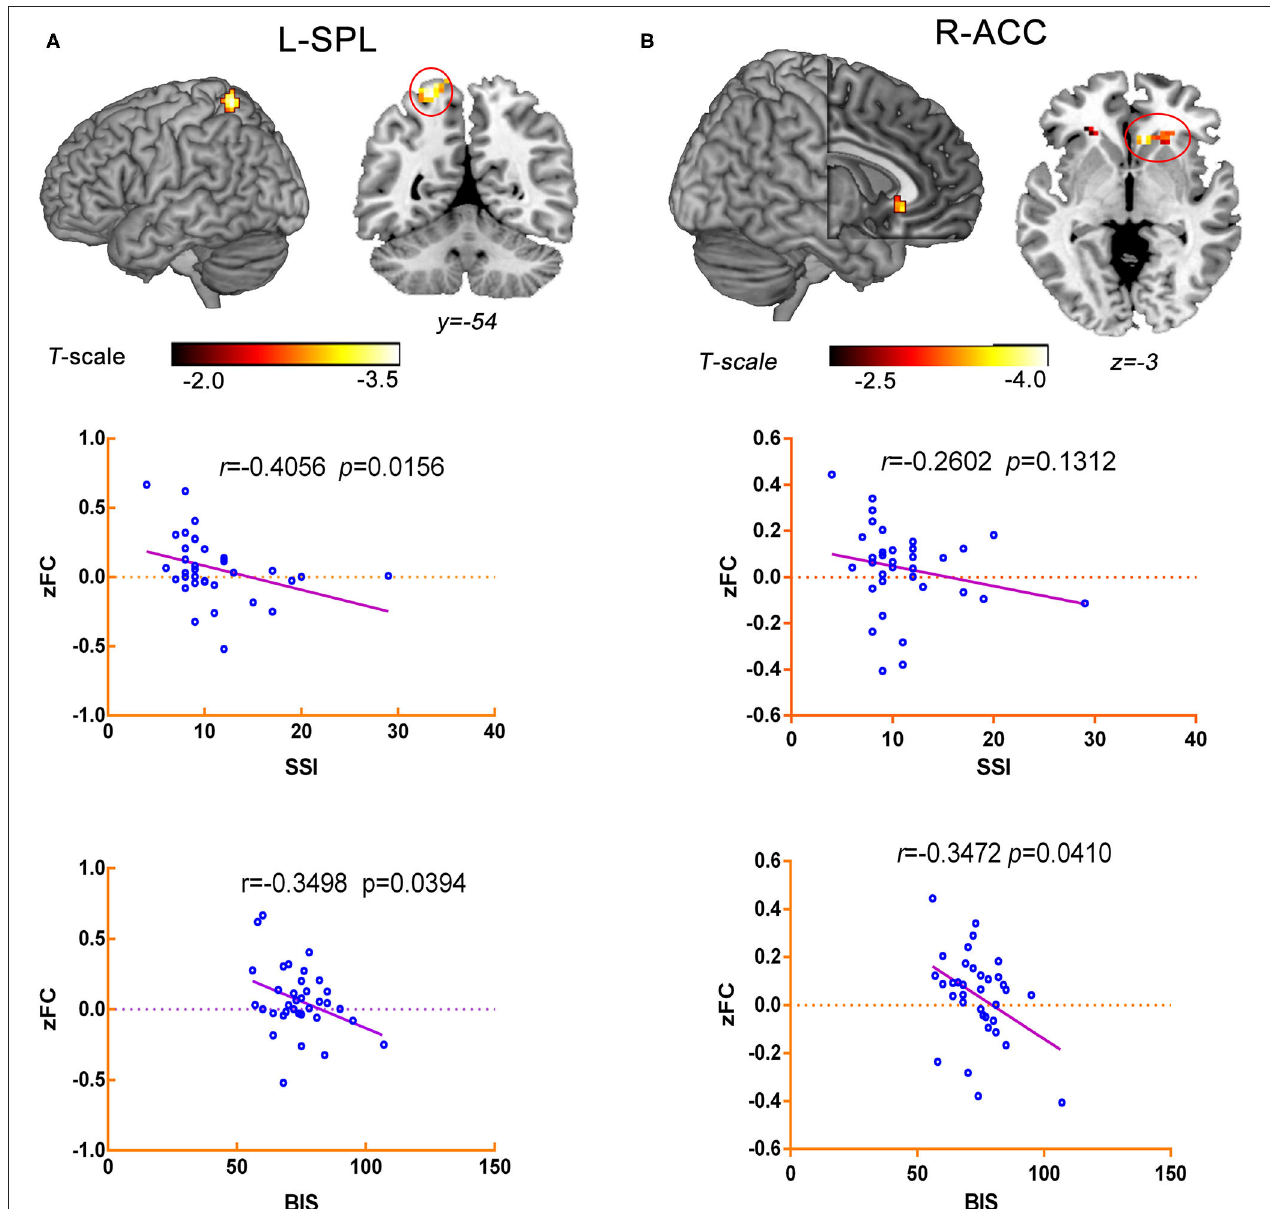
FIGURE 4 | Correlation analysis between aberrant RSFC and the traits of suicide-related behaviour in ATT group. (A) The RSFC between the L-MFG and L-SPG was negatively associated with SSI scores ( r = − 0.4056, p = 0.0156) and BIS scores ( r = − 0.3498, p = 0.0394). (B) The RSFC of the L-SFG with the rACC was negatively correlated with BIS-11 scores ( r = − 0.3472, p = 0.0410), but it was not associated with the SSI total scores ( r = − 0.2602, p =